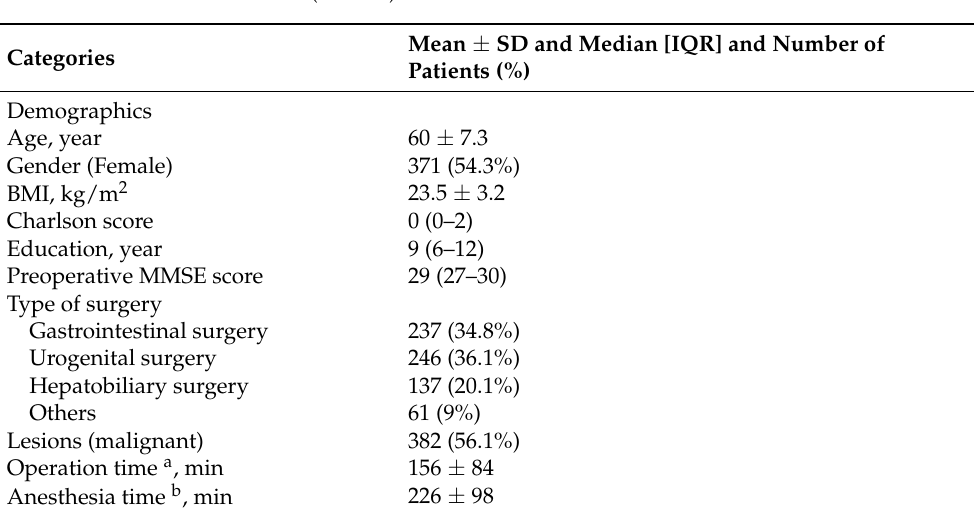
Figure 1. Participants’ recruiting flow chart. The inclusion and exclusion criteria for the propensity score-matched cohort are presented. Table 1. Baseline characteristics (n = 681).